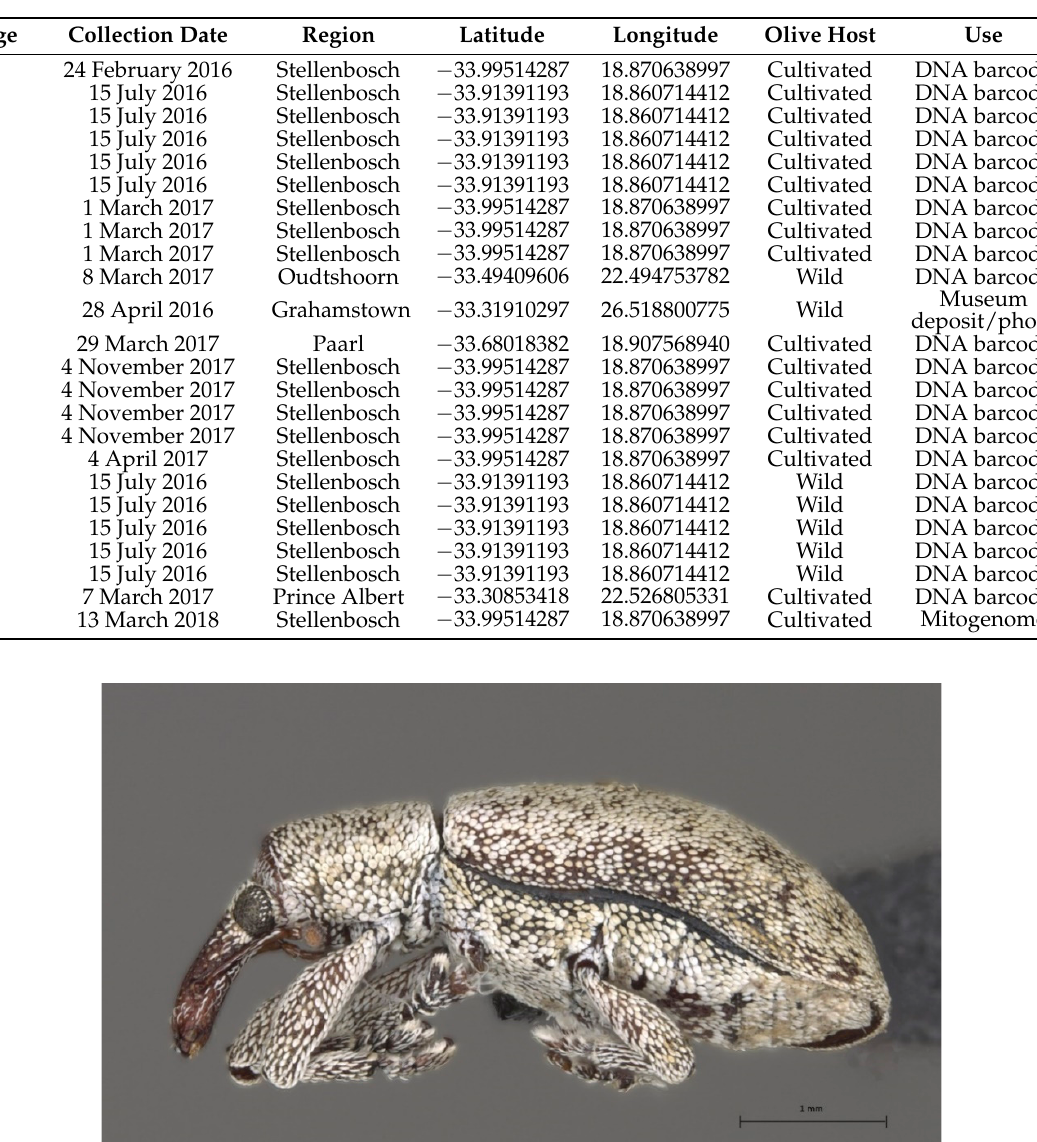
Table 1. List of specimens of Anchonocranus oleae (Coleoptera: Curculionidae), used for DNA analyses (barcoding and sequencing of complete mitochondrial genome) and photographic imaging and deposition in the insect collection of the Iziko Museums of South Africa (Cape Town). Cultivated host— Olea europaea subsp. europaea ; wild host— Olea europaea subsp. cuspidata.